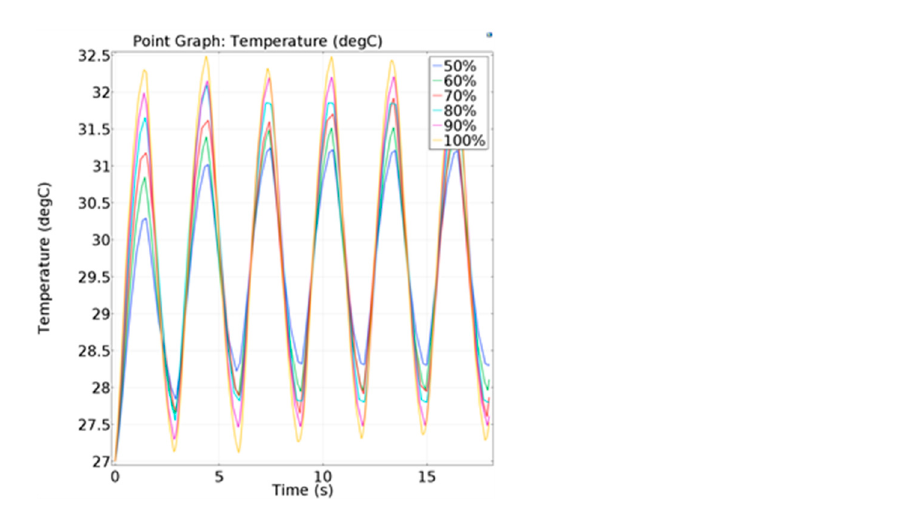
Figure 9. Temperature change of the hot junction under different respiratory flows. Table 2. Average temperature difference of the hot junction under different respiratory flows.